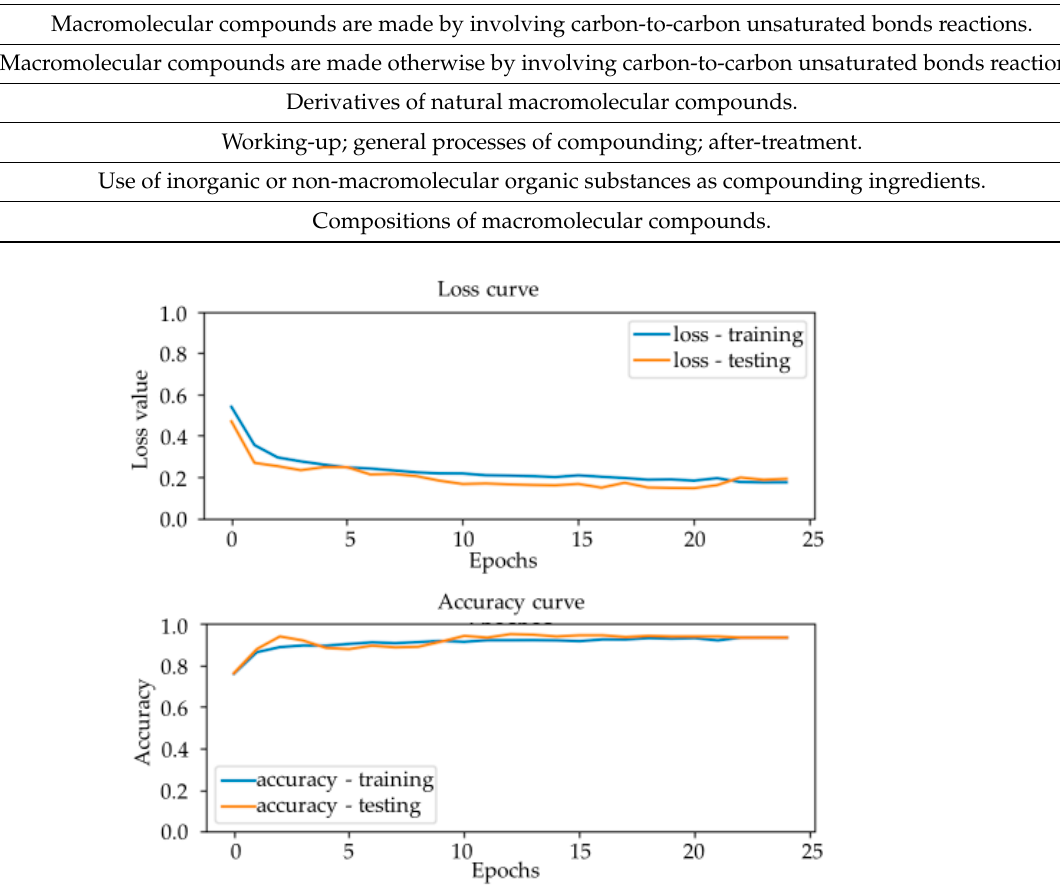
Figure 7. Test results of model loss values and accuracy. Table 3. Sample outputs of chemical and non-chemical paragraph